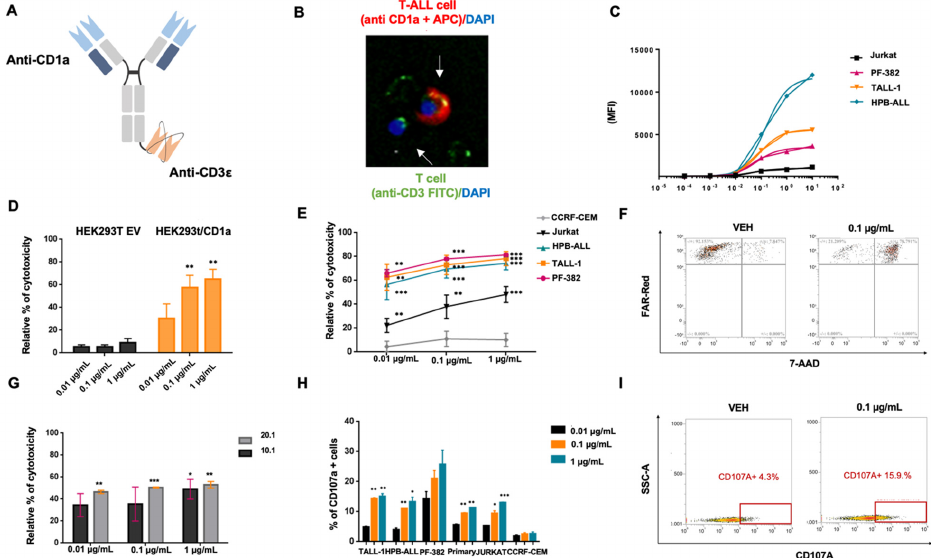
Figure 2. CD1a x CD3 ε BTCE in vitro cytotoxic activity. ( A ) Schematic representation of CD1a x CD3 ε BTCE. ( B ) Coupling of CD3+ T lymphocyte on CD1a+ T-ALL cell by CD1a x CD3 ε BTCE assessed by immunofluorescence microscopy. CD3+ T cells are stained with DAPI (blue) and CD3 FITC (green), CD1a+ T-ALL cells are stained with DAPI (blue) and cell trace Far Red (red). ( C ) Average apparent CD1a x CD3 ε BTCE Kd (0.014 μ g/mL) evaluated on CD1a cortical derived T-ALL cell lines. ( D ) Relative percentage (%) of T cell redirected cytotoxicity of CD1a x CD3 ε BTCE on HEK293T transduced with empty vector (black) and with a vector encoding for CD1a (orange). ( E ) Relative percentage (%) of T cell redirected cytotoxicity of CD1a x CD3 ε BTCE against CD1a+ and CD1a- cortical derived T-ALL cell lines. ( F ) Representative FACS data (dot plots) of T cell redirected cytotoxicity on T-ALL cell line (TALL-1) co-cultured with PBMCs at a 10:1 E:T ratio in the presence of vehicle or 0.1 μ g/mL of CD1a x CD3 ε BTCE. ( G ) Relative percentage (%) of T cell redirected cytotoxicity of 0.1 μ g/mL of CD1a x CD3 ε BTCE against primary CD1a+ T-ALL cells (one representative patient derived sample). ( H ) CD107a concentration-dependent increase on T lymphocytes co-cultured at a 10.1 E:T ratio with both CD1a expressing T-ALL cell lines and primary T-ALL blasts (one representative patient derived sample). ( I ) Representative FACS data (dot plots) of CD107a increase on T lymphocyte co-cultured with T-ALL cells at a 10:1 E:T ratio treated with vehicle or 0.1 µ g/mL of CD1a x CD3 ε BTCE. * p < 0.05, ** p < 0.01, *** p < 0.001. p values are calculated by comparing co-cultures of PBMCs + T-ALL exposed to vehicle with co-cultures of PBMCS + T-ALL treated with increasing concentration of CD1a x CD3 ε (0.01 µ g/mL, 0.1 µ g/mL, and 1 µ g/mL). Relative toxicity is calculated by normalizing CD1a x CD3- treated T-ALL cells co-cultured with PBMCs on negative control (co-cultures of T-ALL cells + PBMCs exposed to vehicle) placed equally to